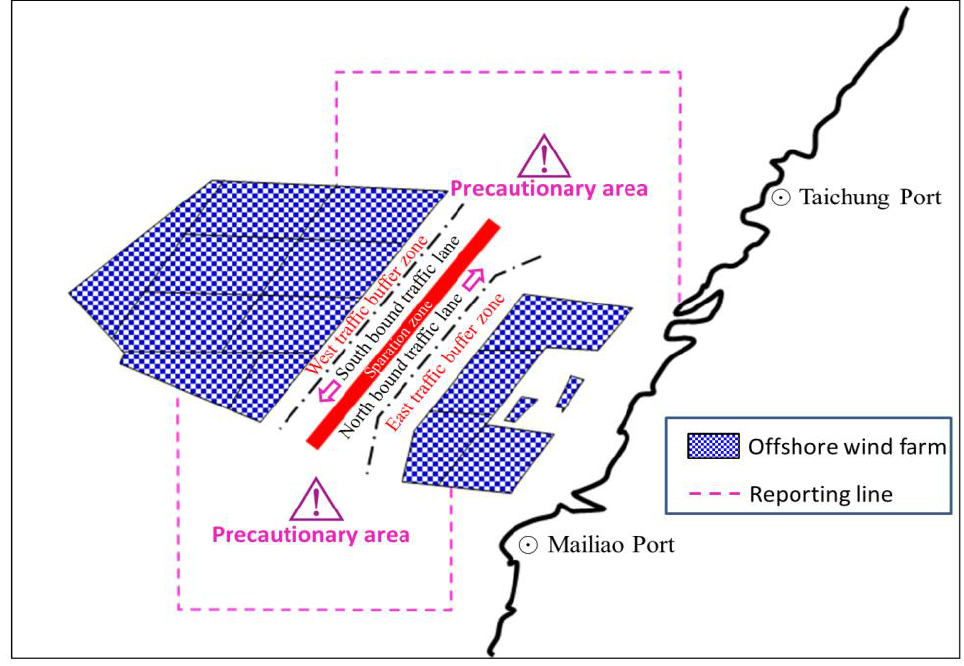
Figure 3. Specified navigation channel of the offshore wind farm close to middle of Taiwan’s west coast. Source: plotted by authors based on the data in Reference [27].